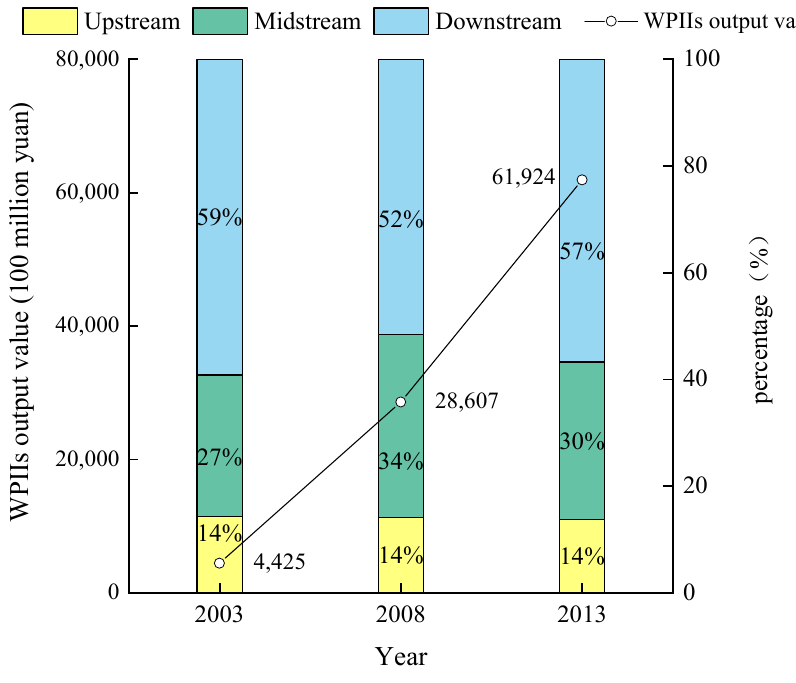
Figure 2. Output value of WPIIs.